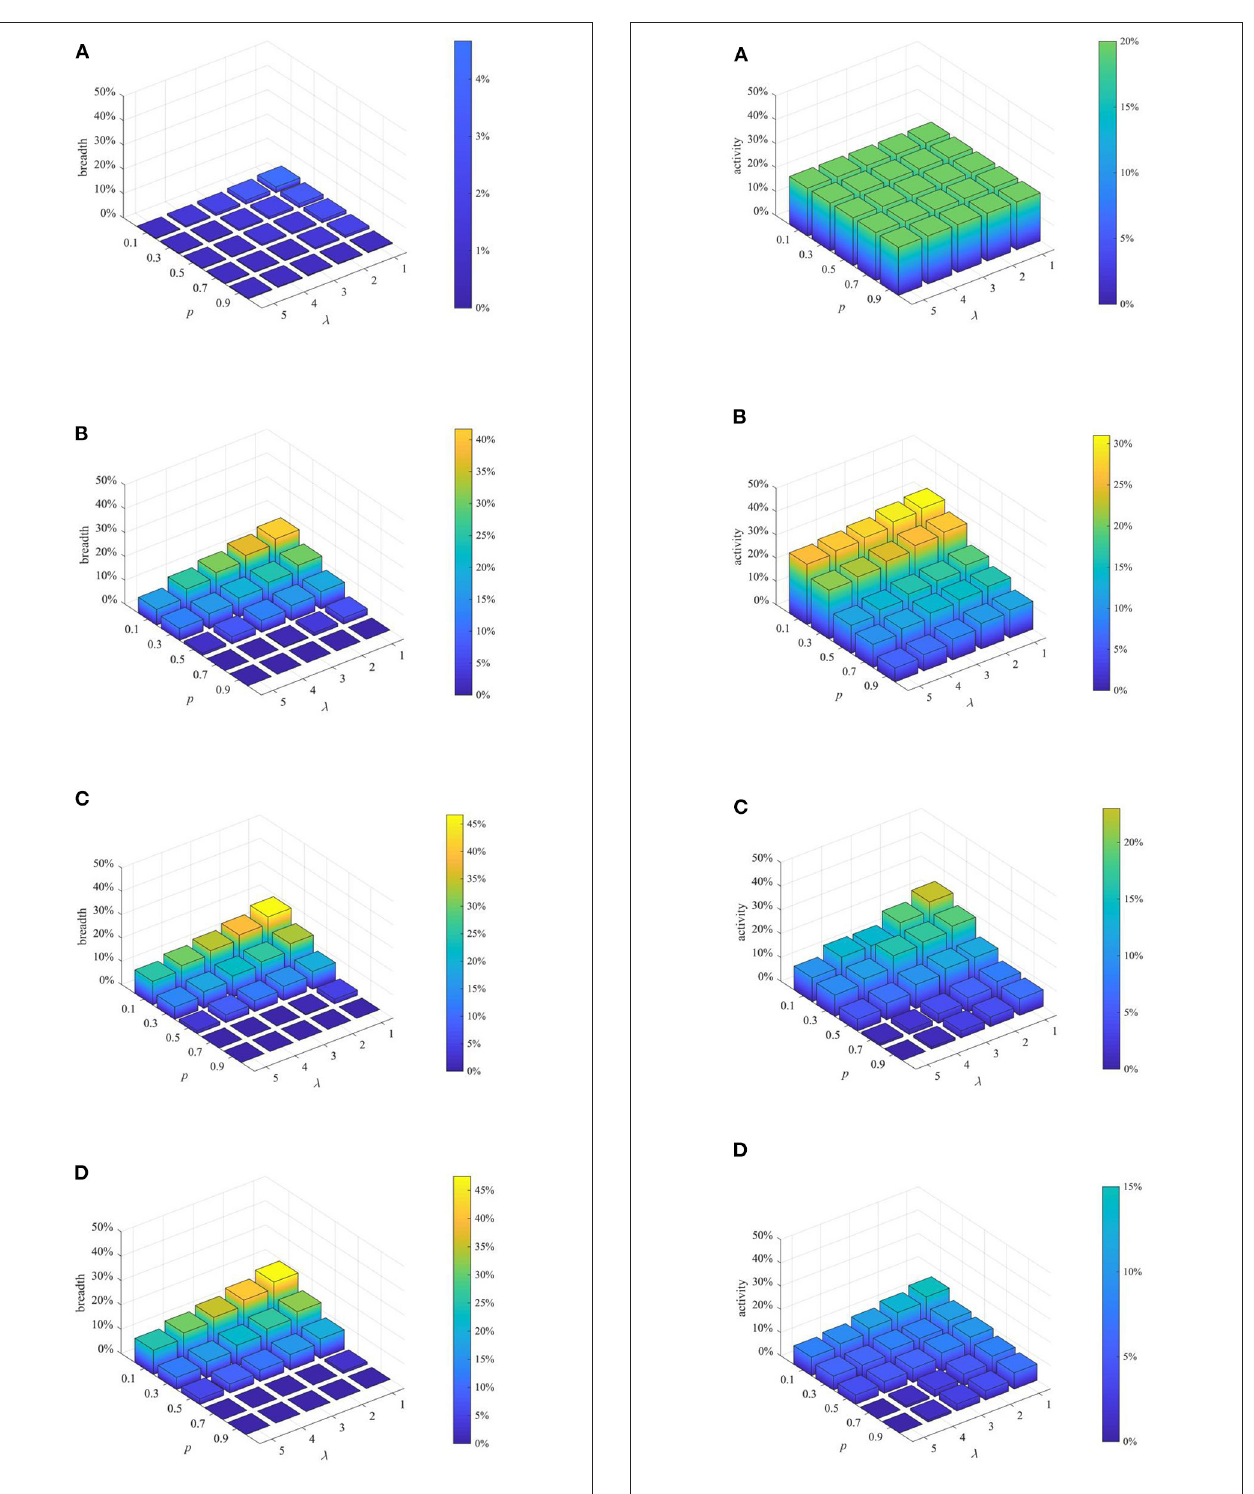
Frontiers in Public Health |